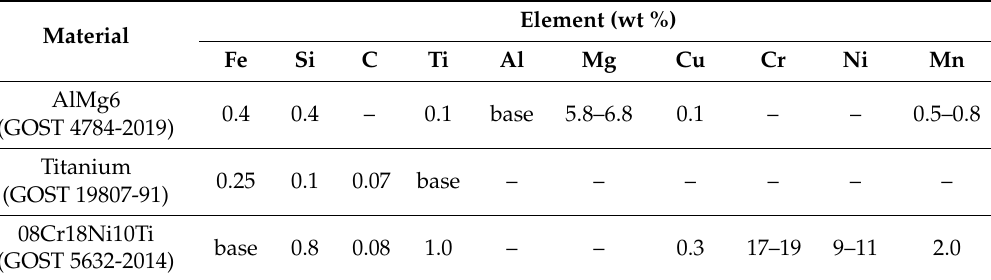
Table 1. The chemical composite (wt %) of initial materials.